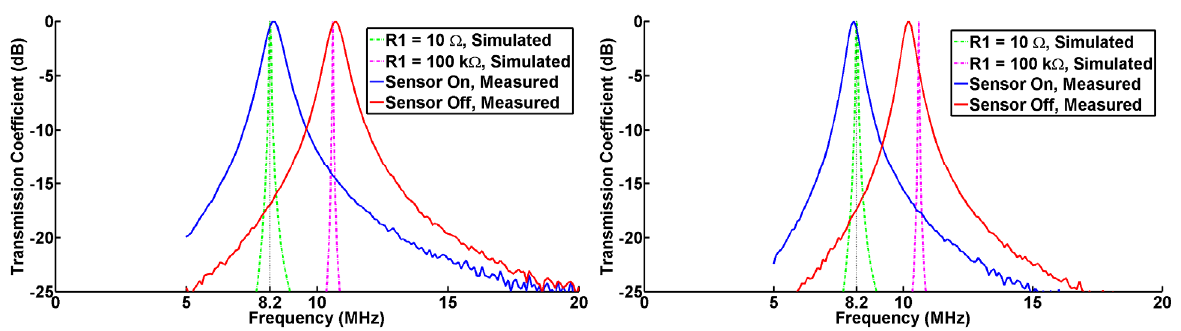
Figure 9. Simulated and measured transmission coefficients for parallel plate tag (left) and interdigital tag (right).